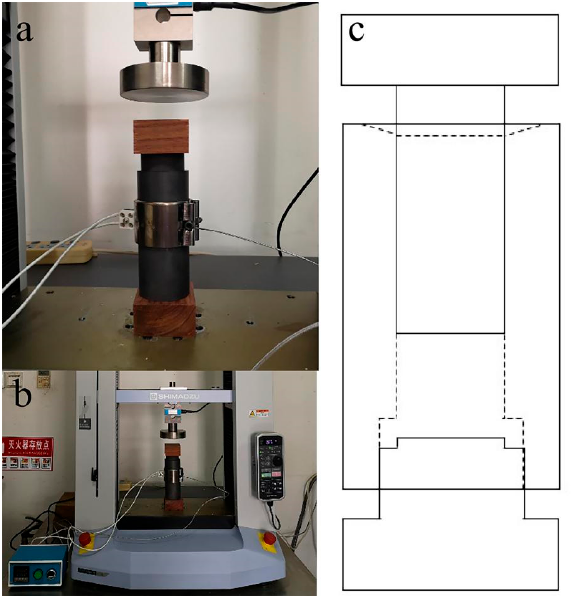
Figure 1. Hot pressing mould and system. ( a ) The self-made pressing mould. ( b ) Hot pressing system. ( c ) Structure chart of pressing mould. ( c ) Structure chart of pressing